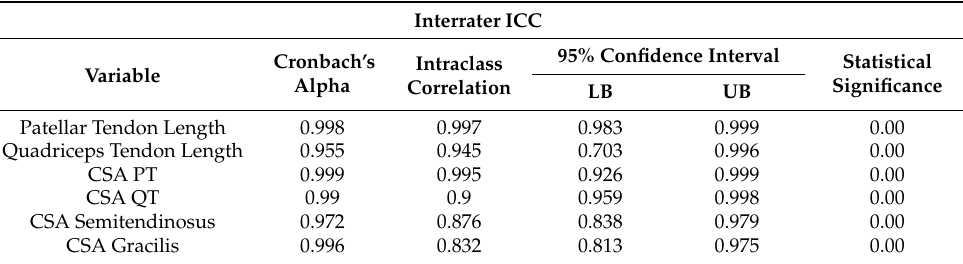
Table A1. Interrater reliability results, n = 30. CSA, cross-sectional area; PT, patellar tendon; QT, quadriceps tendon; UB, upper border; UL, lower border.